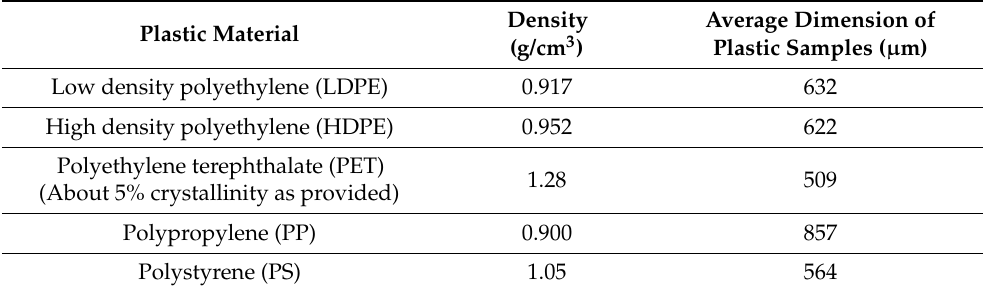
Table 1. Pristine plastic materials used in the present study, density, and average dimension of the plastic